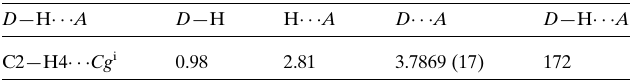
Crystal data Chemical formula